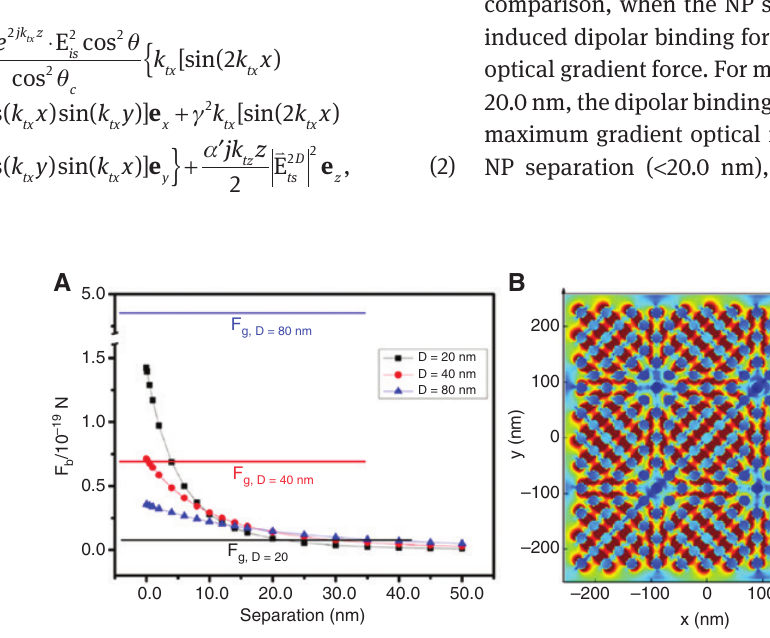
Figure 2: Optical force calculations and dipolar coupling in the orthogonal LSEW fields. (A) Optical forces exerted on the colloidal silver NPs with different diameters at an illuminating laser intensity of 0.25 W cm −2 . (B) Dipole-dipole coupling pattern of the polarized NPs in the orthogonal LSEW